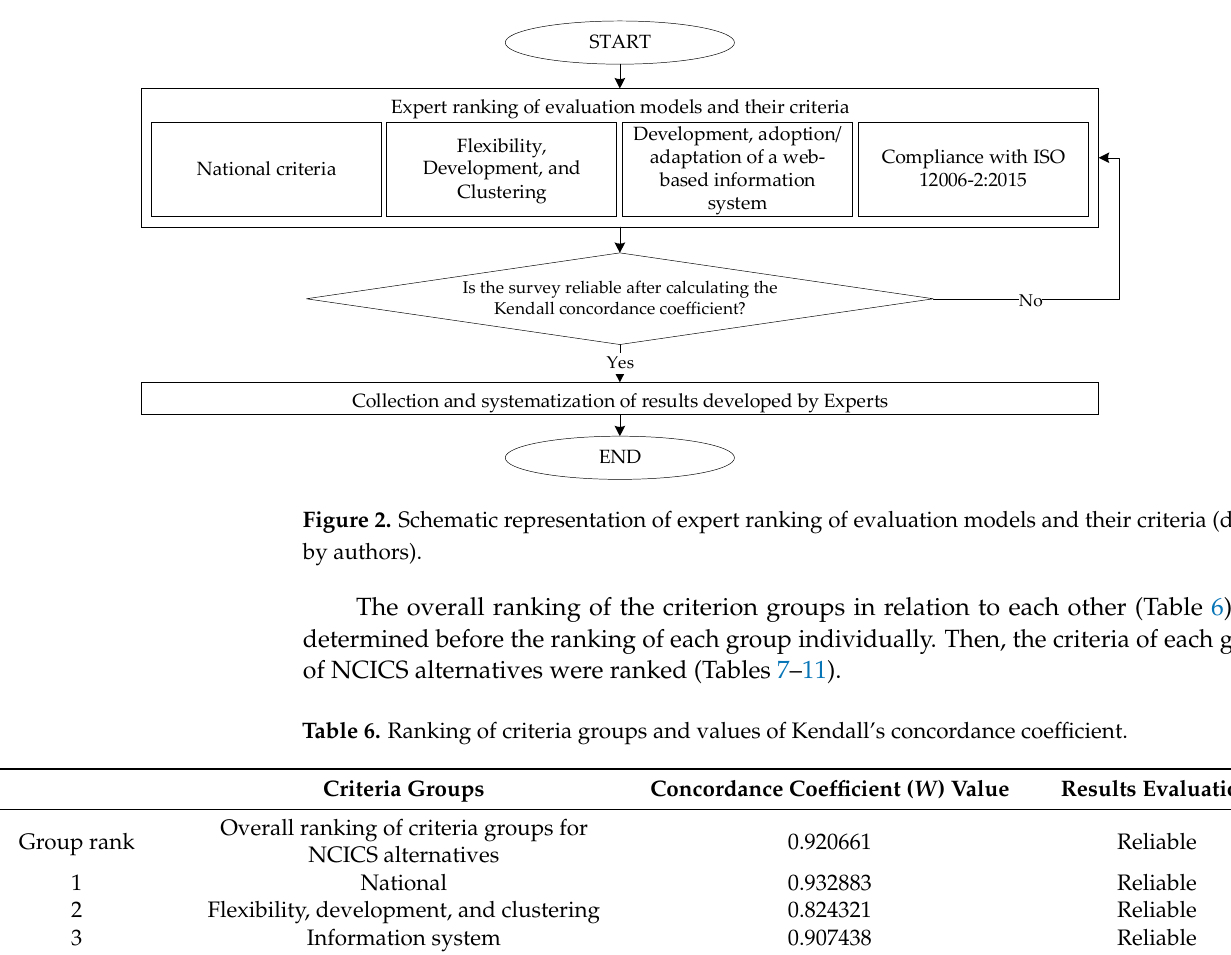
Table 7. National evaluation criteria for NCICS alternatives, their ranking in importance order, and compliance with